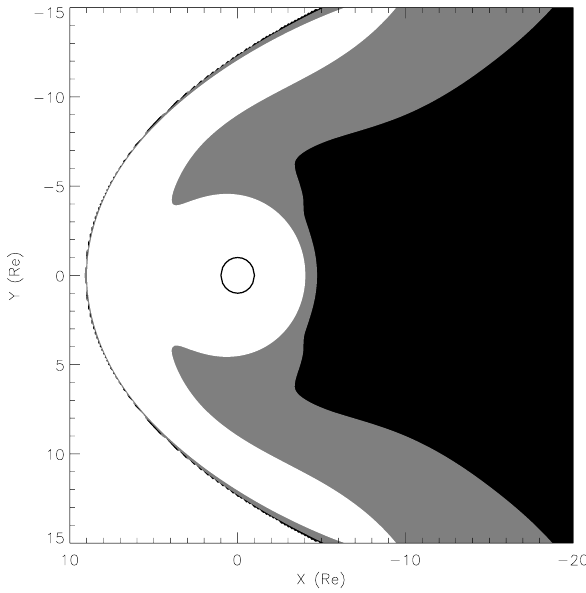
Fig. 7. The spatial distribution of κ< 3 for 20keV O + (gray and black) and protons (black) in the equatorial plane of the magneto- sphere based on T96 model with D st =− 100nT and Solar Wind Pressure=10nPa.